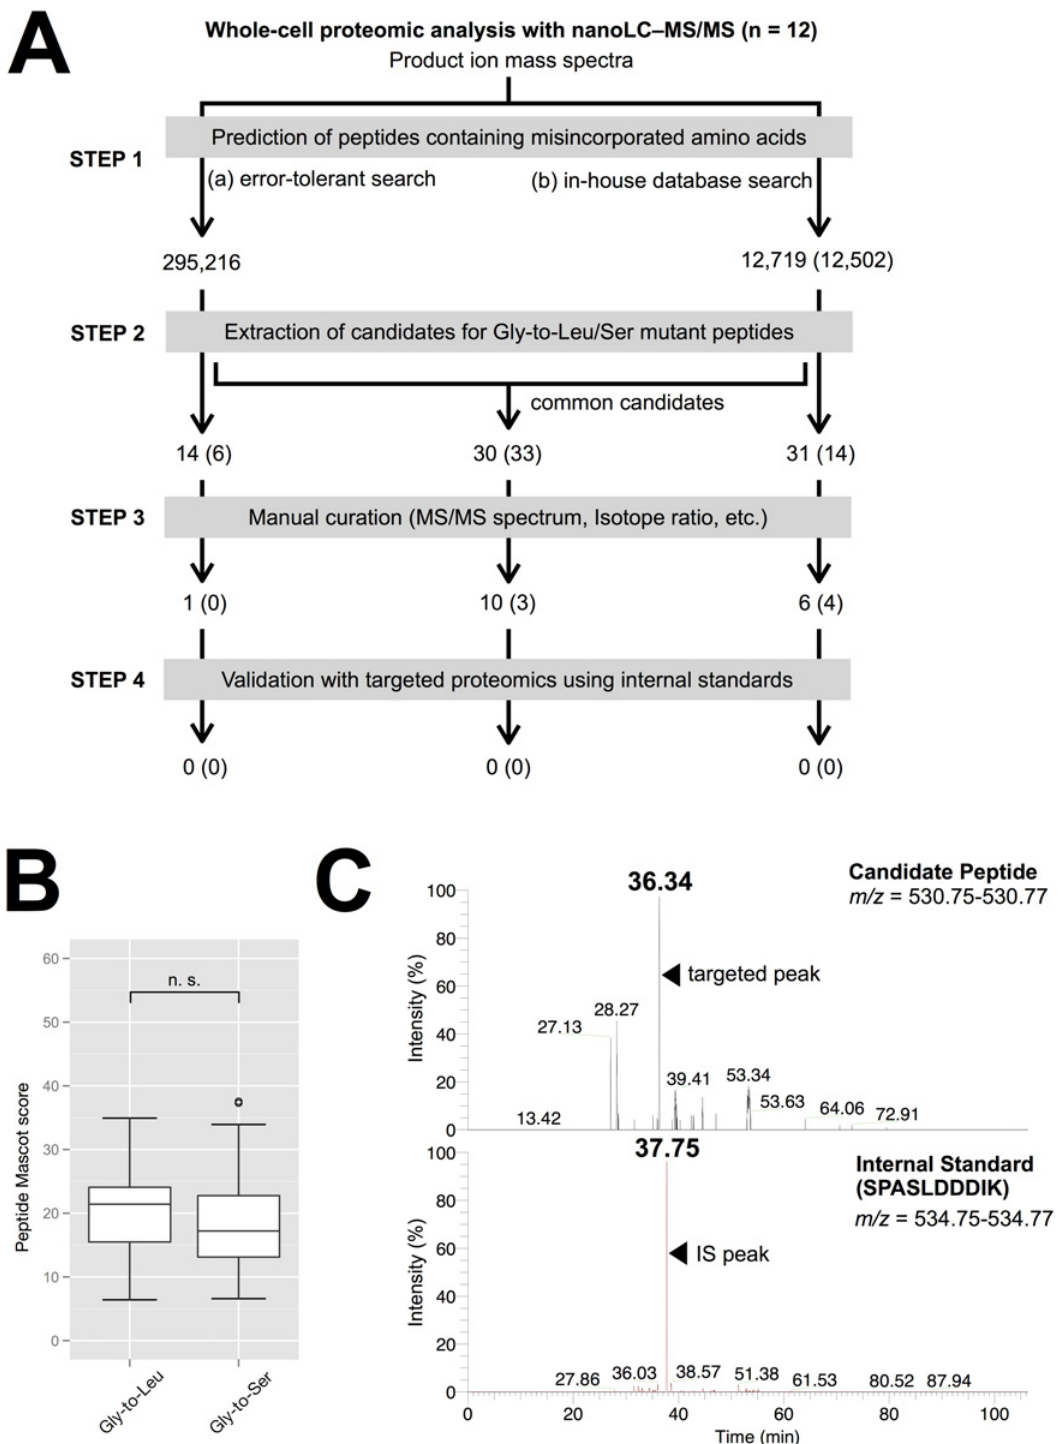
Figure 3. Screening for mutant peptides resulting from nev-tRNA Gly -dependent decoding. (A) Summary of the whole-cell proteome analysis of mixed- stage C. elegans . Values are the unique peptide counts at each step. Values in parentheses are the count of candidate peptides containing misincorporated Ser at the Gly (GGG) codon (negative control). (B) Boxplot of the confidence scores for the candidate peptides in Step 2. Significant differences were determined with Student ’ s two-sided t test. (C) Example of the validation of targeted proteomics. Extracted ion chromatograms of the candidate peptide and the synthetic peptide SPASLDDDIK (an internal standard) are shown. The candidate peptide ion was separated > 1.0 min earlier than the internal standard, indicating that the amino acid sequence of the candidate peptide was inconsistent with the sequence SPASLDDDIK. doi:10.1371/journal.pone.0116981.g003 PLOS ONE | DOI:10.1371/journal.pone.0116981 January 20,